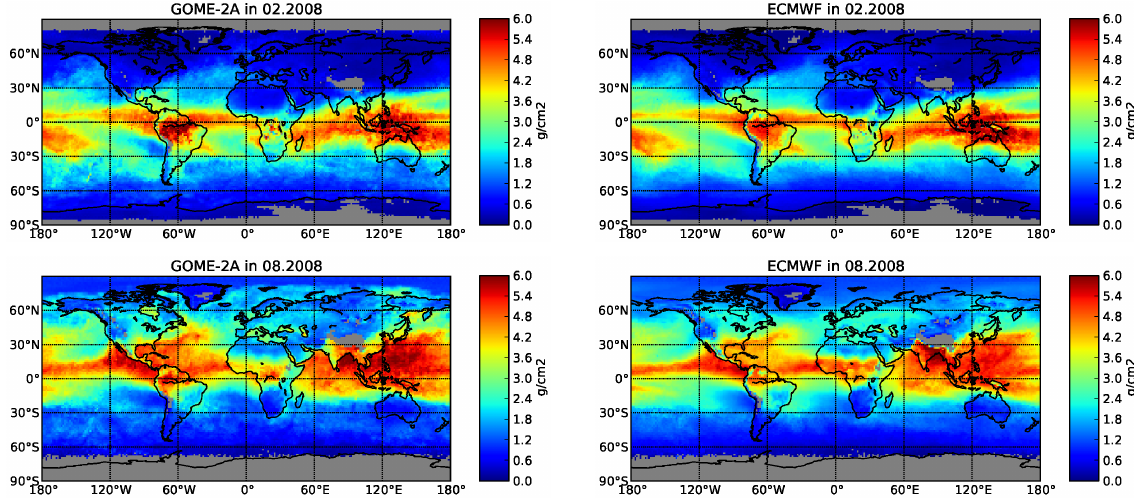
Figure 10. Monthly mean maps of total column water vapour from GOME-2A (on the left) and ECMWF ERA-Interim (on the right) co-located data for February 2008 (on the top) and August 2008 (on the bottom). Only cloud-screened data have been